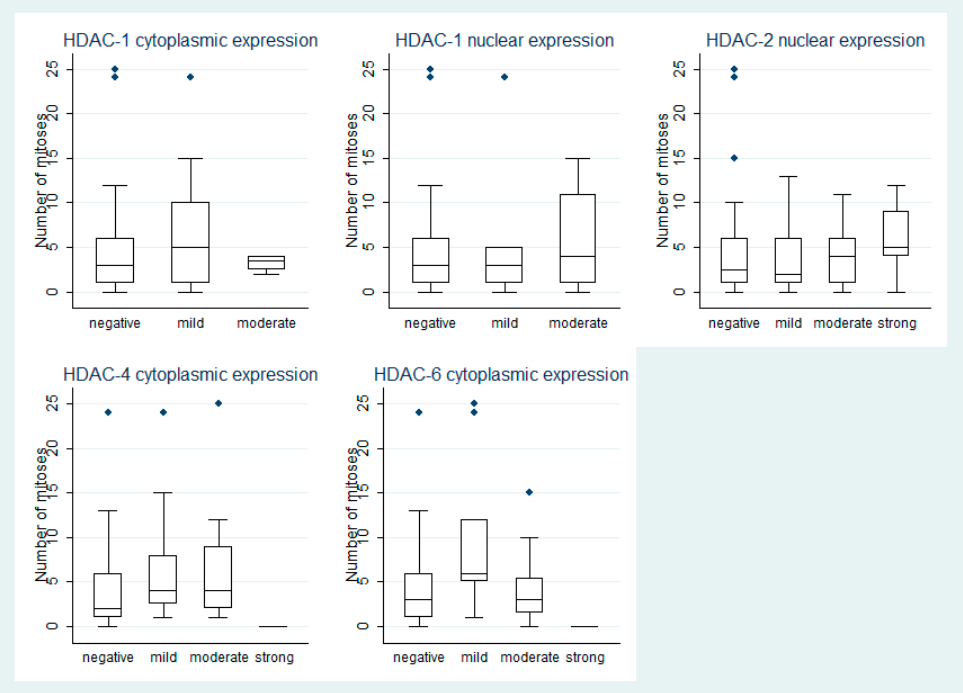
Figure 3. Schematic representation of the associations between HDAC-1, -2, -4, and -6 expression with number of mitoses.